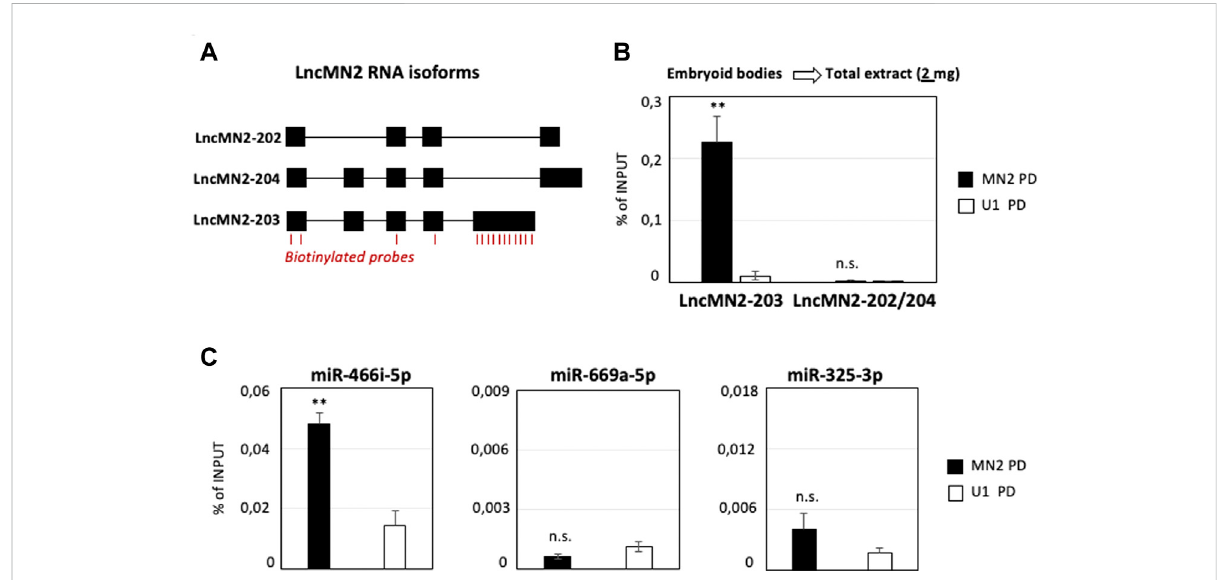
FIGURE 1 LncMN2-203 RNA pull-down in mESCs-derived embryoid bodies. (A) Block-and-line scheme representing the structure of the three lncMN2 RNA isoforms (Carvelli et al., 2022). Exon (black blocks)/intron (thin lines). The position of the antisense probes used for the RNA pull-down experiments is highlighted in red. (B) Quanti fi cation by qRT-PCR of lncMN2-203 and lncMN2-202/204 recoveries from lncMN2-203 (MN2) or control (U1 snRNA) RNA pull-down experiments. A total of 2 mg cell extracts prepared from differentiated EB6 were used for each reaction. LncRNA enrichments are expressed as Input percentage (%). Error bars represent SEM. n = 3 biological replicates. (C) Quanti fi cation by qRT-PCR of miR-466i-5p (Left), miR-669a-5p (Middle) and miR-325-3p (Right) recoveries from lncMN2-203 (MN2) or control (U1 snRNA) pull-down experiments.MiRNAenrichmentsareexpressedasInputpercentage(%).ErrorbarsrepresentSEM. n =3biologicalreplicates.Datainformation:** p ≤ 0.01, n. s. > 0.05 (two-tailed, unpaired Student ’ s